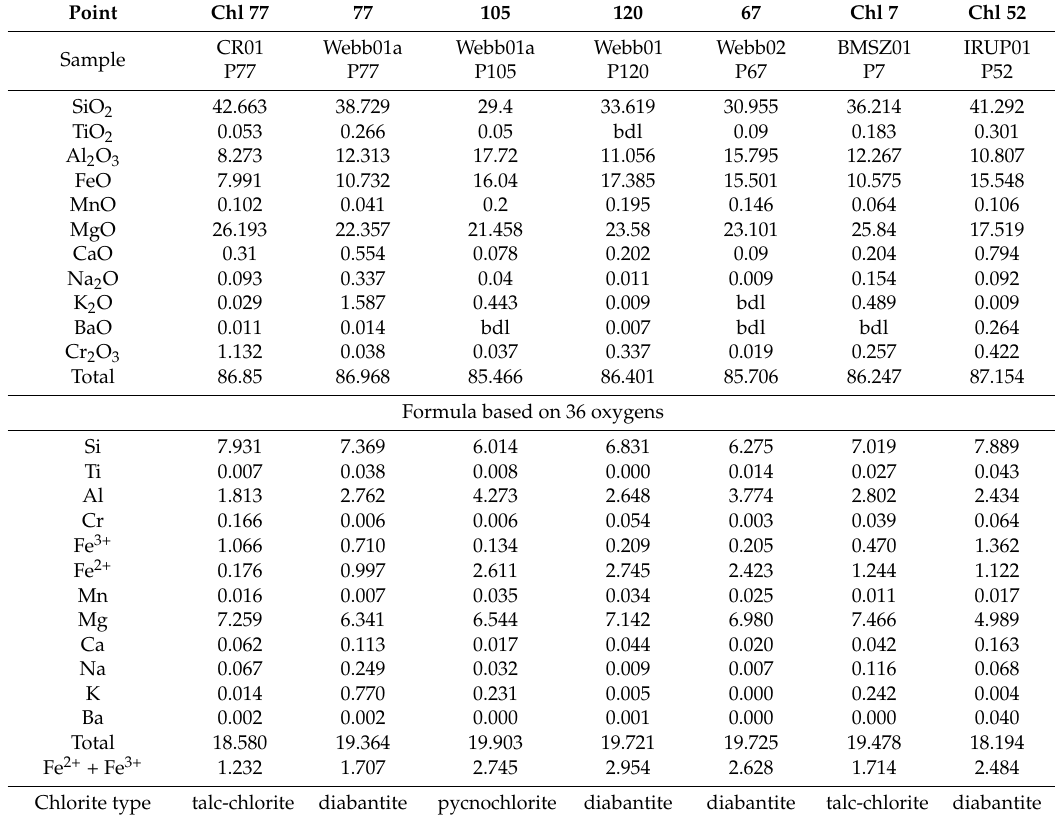
Table 7. Representative chlorite analyses in wt